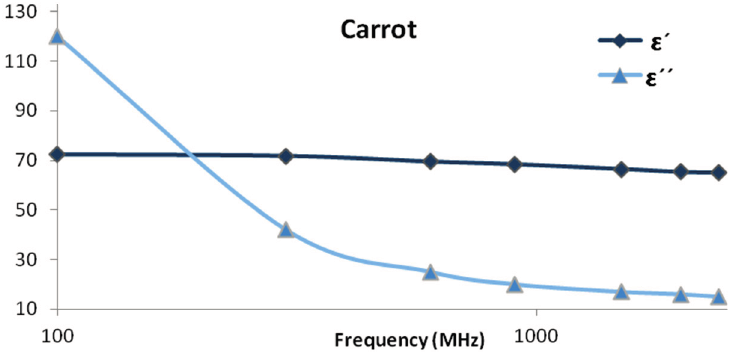
Figure 1. Example of ε′ and ε″ variations with frequency on a logarithmic